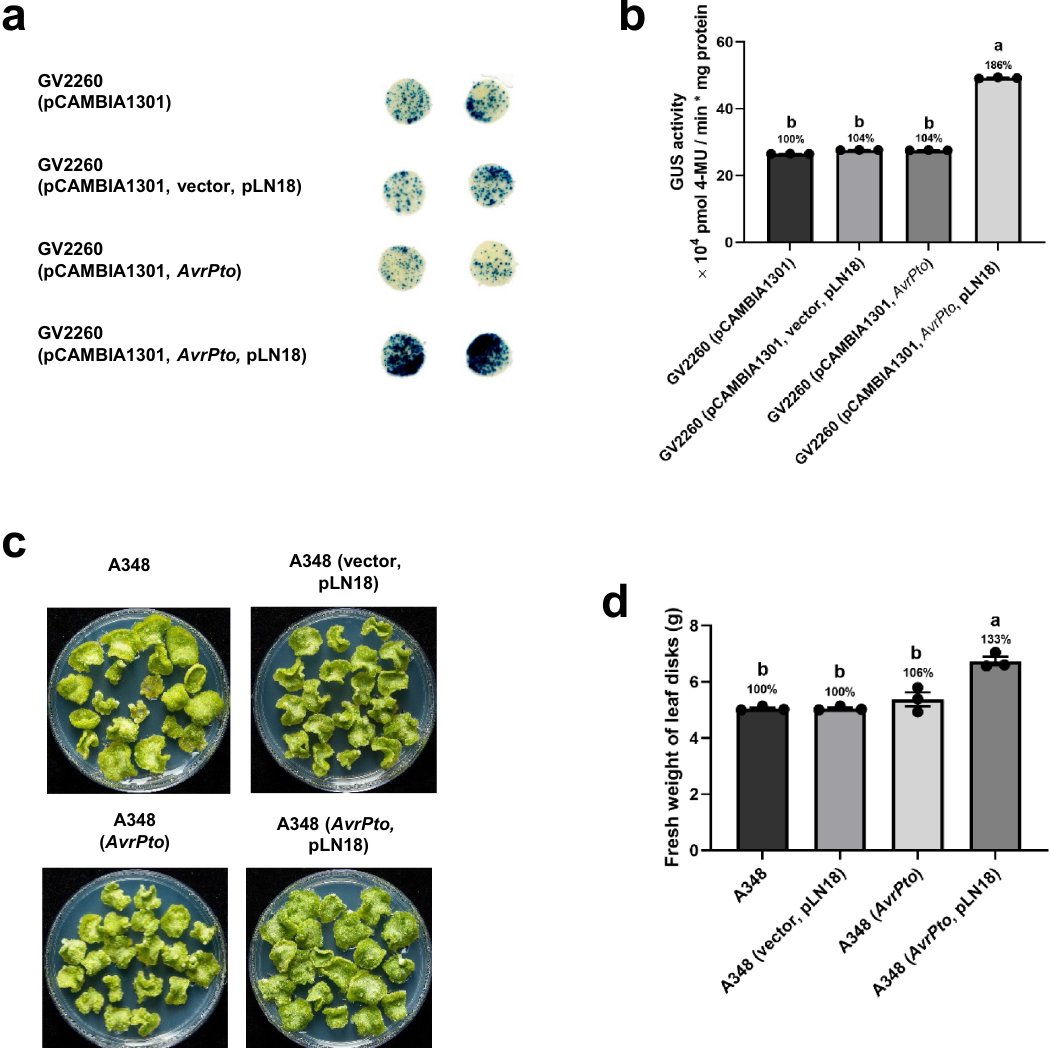
Fig. 3 Engineered A. tumefaciens strains expressing a T3SS and AvrPto increase the transient and stable transformation ef fi ciency of N. benthamiana. a, b Transient transformation assay. a GUS staining of N. benthamiana leaf disks in fi ltrated with A. tumefaciens strain GV2260 (A 600 = 0.0005) harboring pCAMBIA1301 and expressing AvrPto in combination with or without pLN18. A. tumefaciens strains GV2260 (pCAMBIA1301) and GV2260 (pCAMBIA1301, vector, pLN18) were also included as controls. Four days after in fi ltration, the leaf disks were stained with X-gluc and photographed. b Quantitative fl uorometric GUS assays with extracts from leaves of plants treated as in a . c , d Leaf disk transformation assay. c N. benthamiana leaf disks were infected with the tumorigenic A. tumefaciens strain A348 (A 600 = 0.1) expressing AvrPto with and without pLN18. A. tumefaciens strains A348 and A348 (vector, pLN18) were also included as negative controls. Photographs were taken 10 days after A. tumefaciens infection. d Fresh weight of leaf disks was evaluated from the experiment in c . Data presented in b and d are mean ± standard error of three replicates. Bars with different letters are signi fi cantly different based on Tukey ’ s post-hoc one-way ANOVA analysis ( p < 0.05). Brown-Forsythe test was done to test for variance ( p = 0.2380 for b and 0.3645 for d ). Experiments were repeated three times with similar results. Source data are provided as a Source Data fi cause disease 14 . To further examine the effect of other T3Es on AMT, we selected two T3Es from P. syringae pv. tomato :